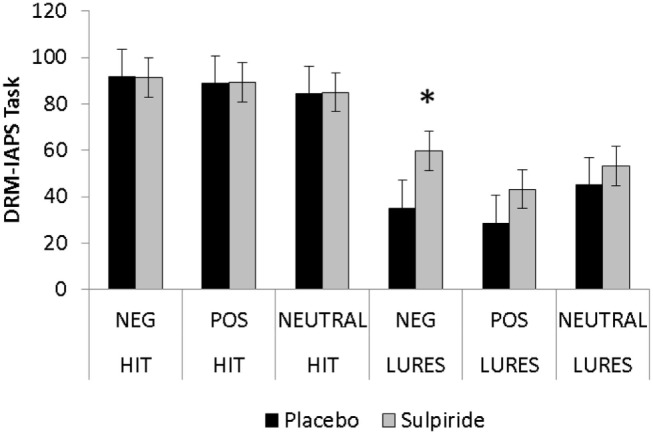
Percentage of true and false recognition in the DRM–IAPS paradigm comparing the sulpiride and placebo groups. Error bars are SEMs; *p < 0.05.